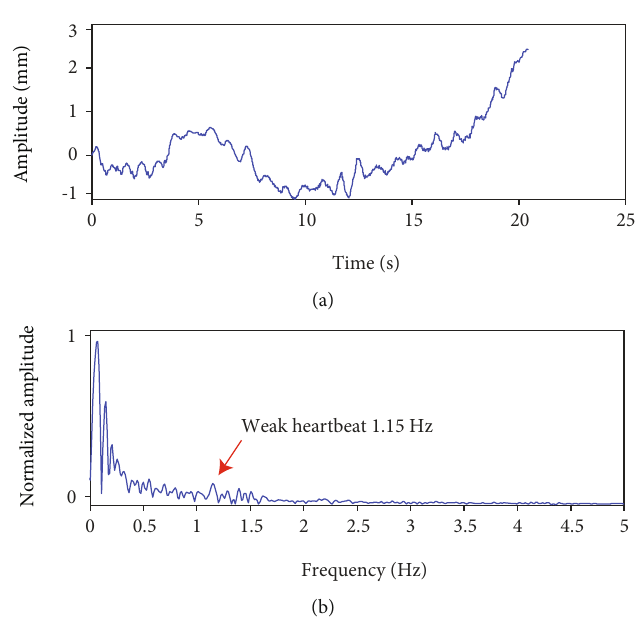
Figure 12: The demodulation result when using the fi xed DC o ff set method. (a) In time domain. (b) In frequency